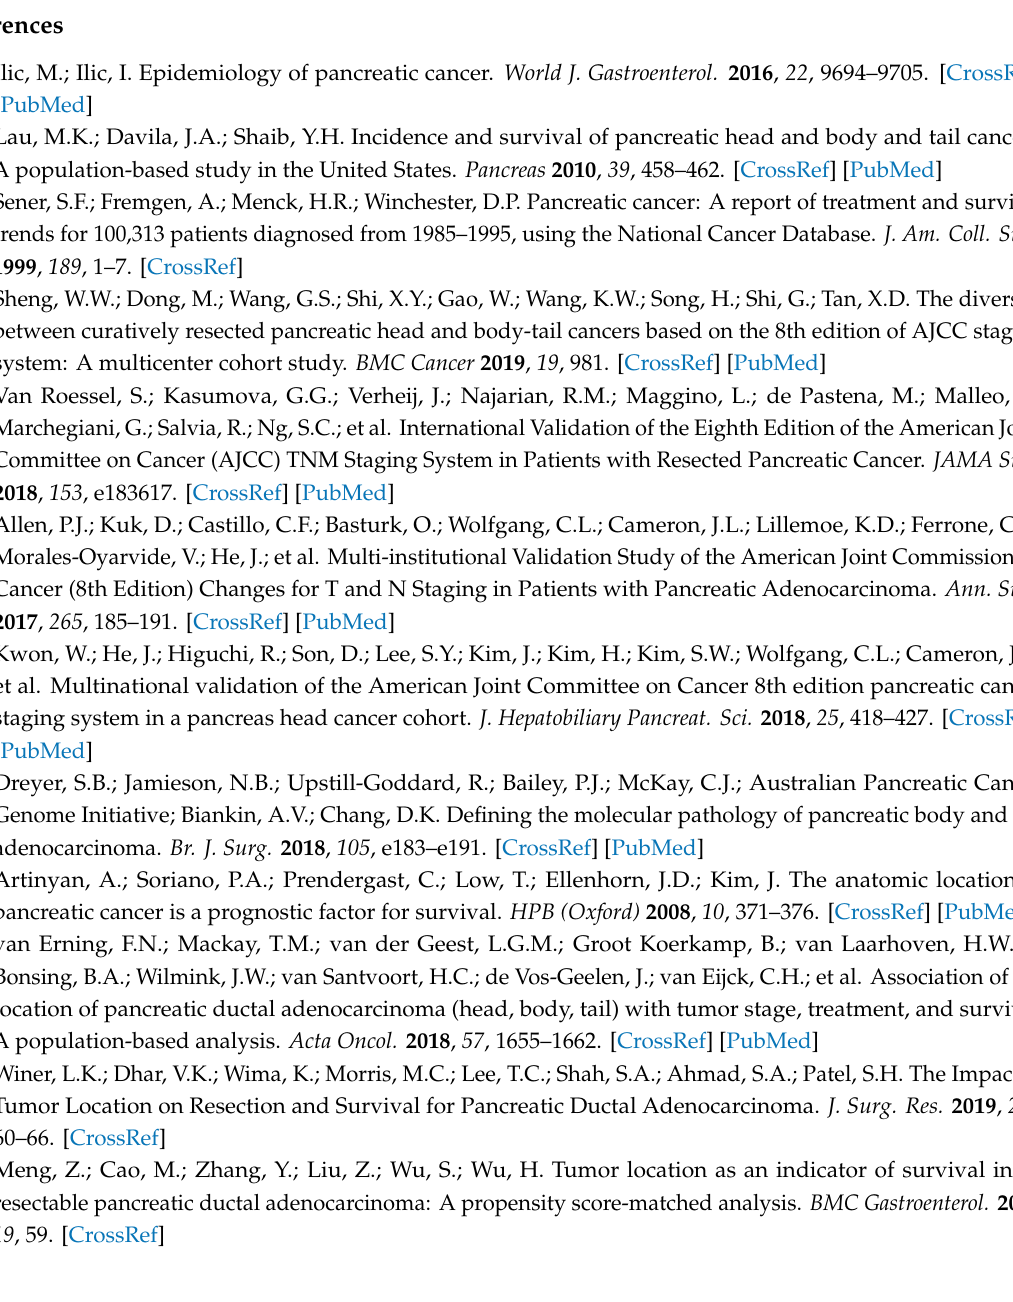
Figure S1: The survival curves of pancreas head / uncinate cancer and pancreas body cancer in terms of the prognostic group, according to the eighth edition of AJCC cancer staging